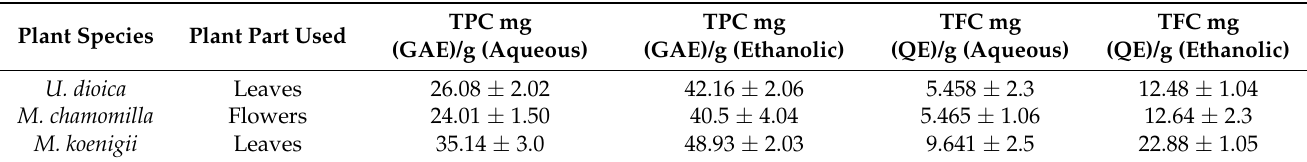
Figure 3. Total ( a ) phenolic and ( b ) flavonoid contents of aqueous and ethanolic fractions of U. dioica , M. chamomilla , and M. koenigii . Data are shown as the mean ± SD for n = 3. Statistical significance is ascribed as * p < 0.05 (intragroup) and # p < 0.05 (intergroup) of the respective groups. Table 3. TPC and TFC results of UD, MC, and MK are expressed in mean ± SD.